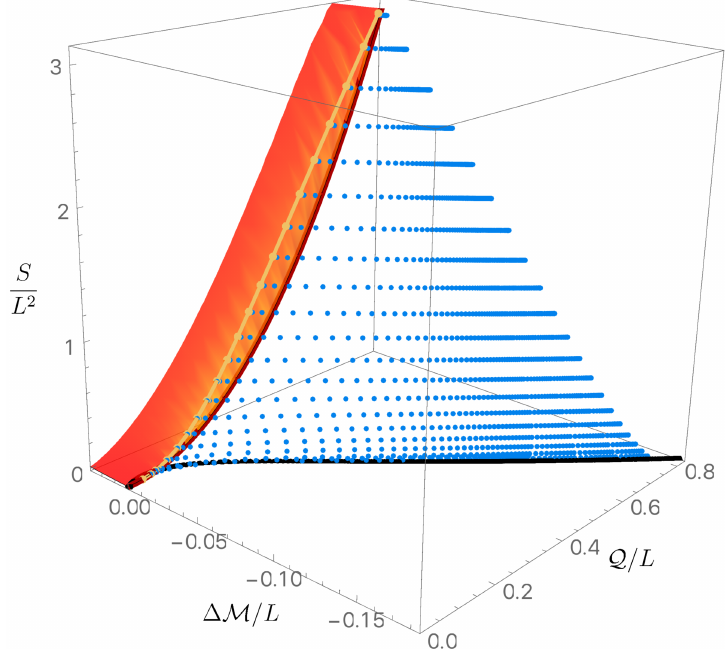
Figure 9 . Entropy as a function of the quasilocal charge and mass difference for Einstein theory with a scalar field charge e = 2 ( e ) in a Minkowski box. When they coexist with RN c ≤ e < e S BHs, for a given ( Q , M ) /L , hairy BHs always have more entropy than RN, i.e. they dominate the microcanonical ensemble. For e , when Q > Q ( e ) , hairy BHs have a zero entropy c ≤ e < e S ? limit where they coincide with the soliton (black disk) curve in the sense that they have the same ( Q , M ) /L as the soliton (the temperature and horizon curvature diverges). However, when 0 < Q < Q ? ( e ) , hairy BHs terminate at an extremal BH ( i.e. with zero temperature) and finite entropy (and divergent horizon curvature) along a line that does not coincide with the black disk one for the